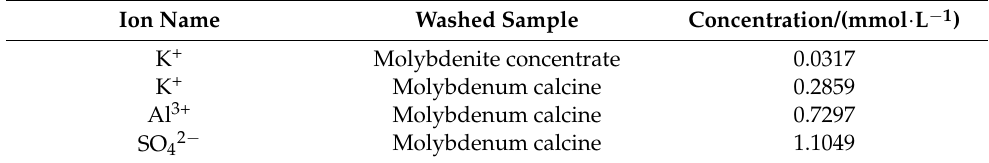
Table 3. Ion contents in the washing